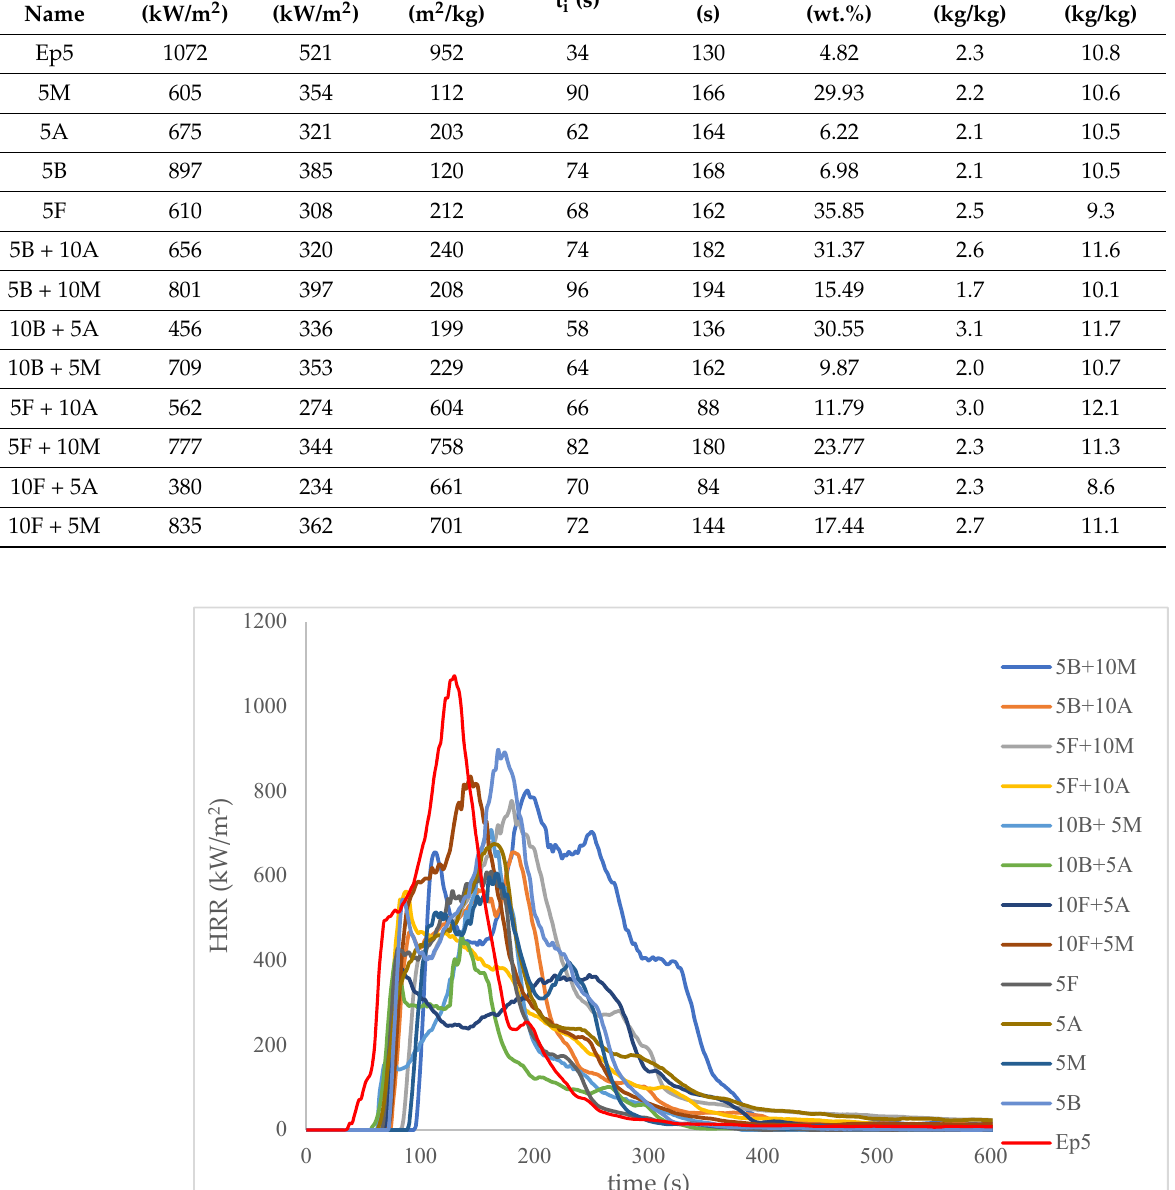
Table 3. Thermokinetic properties of epoxy materials produced from unmodified and modified Ep5 exposed to heat flux equal to 30 kW/m 2 (piloted ignition) .